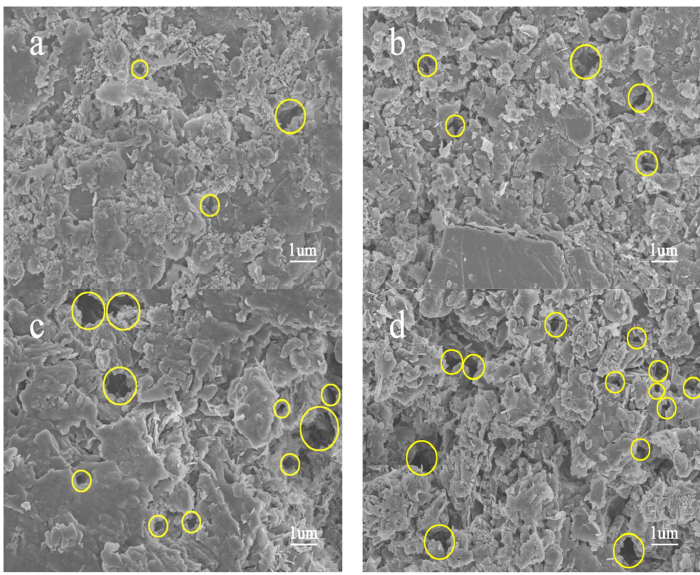
Figure 4. SEM images of spent shale samples extracted by sub-critical water for 150 h, at: ( a ) 310 ◦ C; ( b ) 330 ◦ C; ( c ) 350 ◦ C; and ( d ) 365 ◦ C extraction,